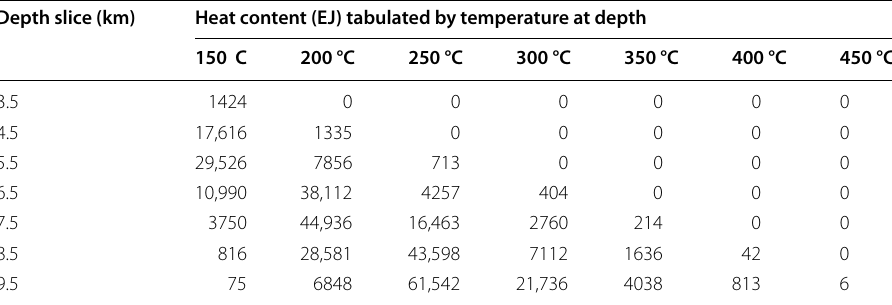
Table 2 Available heat or heat in place, within the basement for the depth range 3.5– 9.5